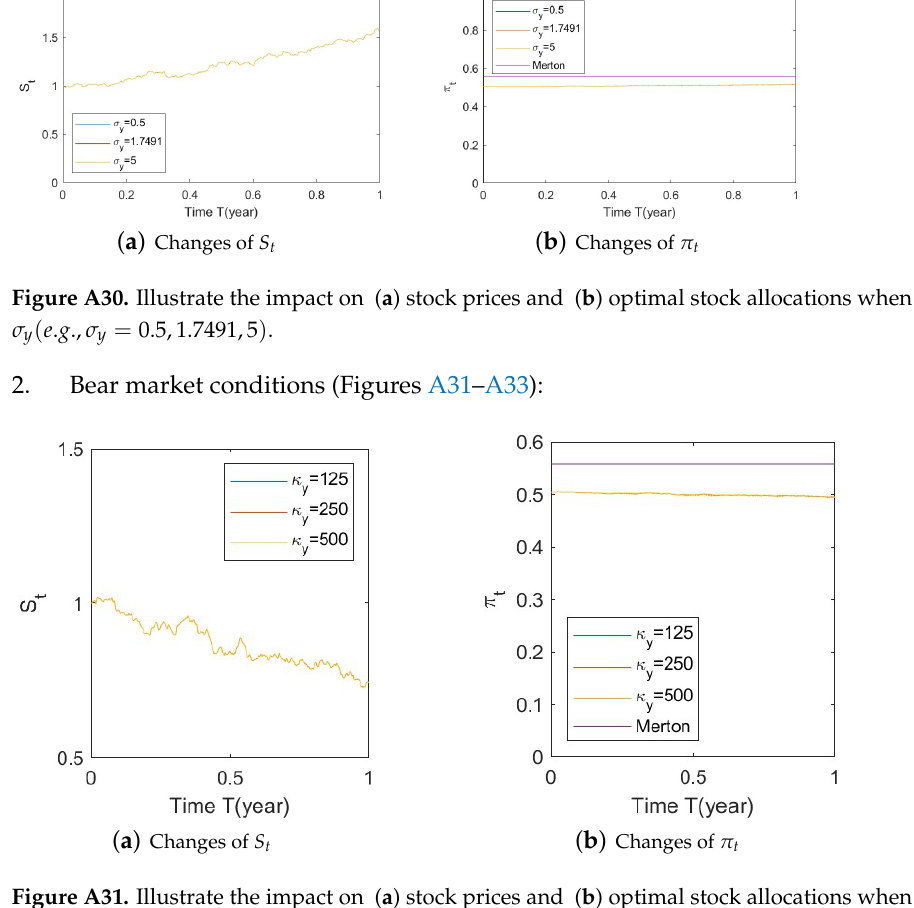
Figure A31. Illustrate the impact on ( a ) stock prices and ( b ) optimal stock allocations when varying the speed of reversion, κ y ( e . g ., κ y = 125,250,500 ) .